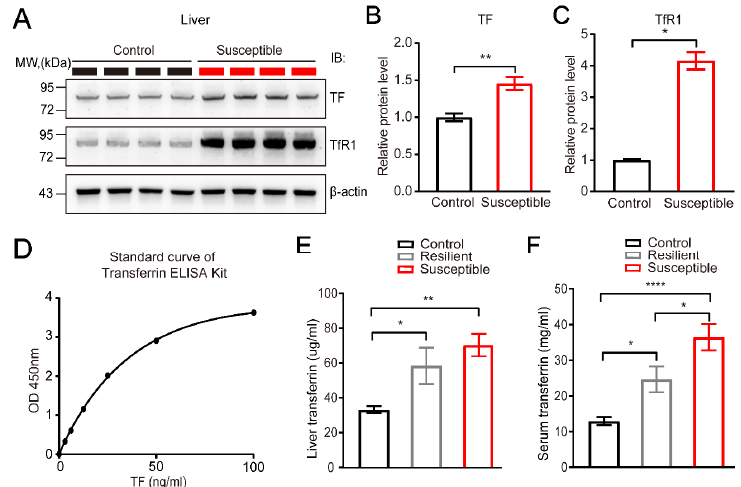
Figure 3. The elevated expression of TF and TfR1 in peripheral tissue induced by CSDS. ( A – C ) Repre-